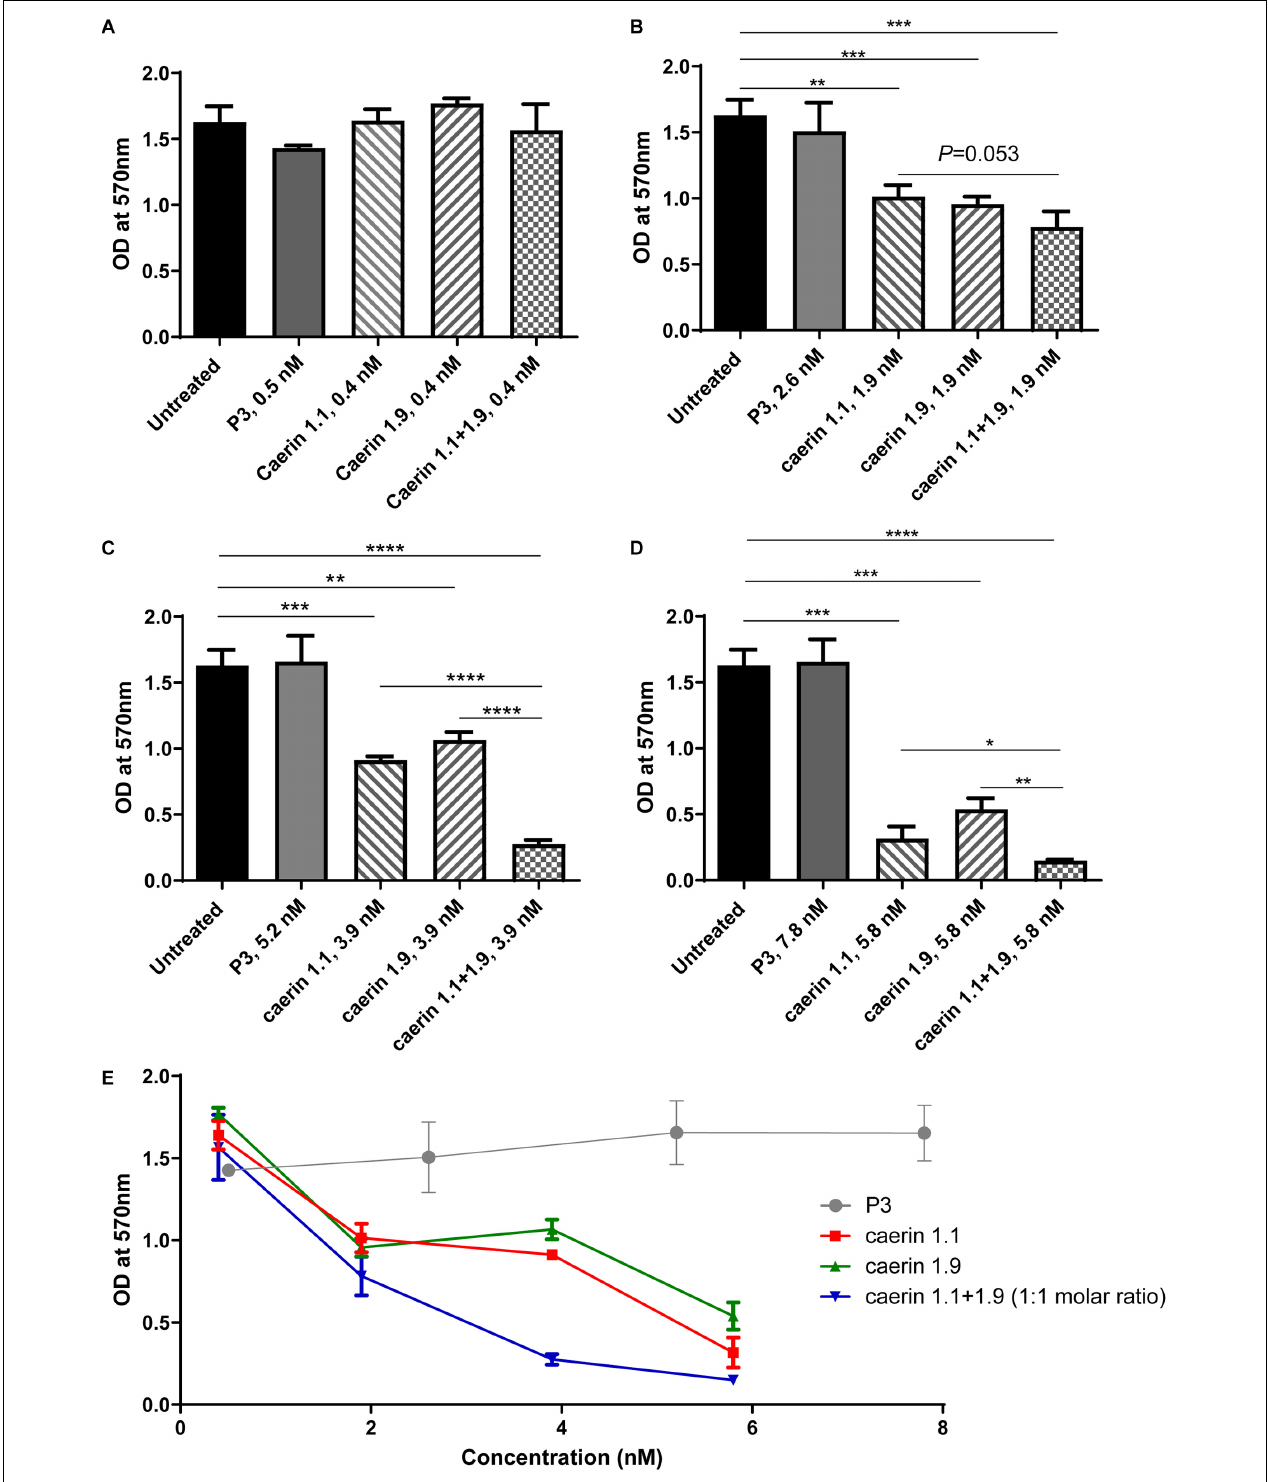
FIGURE 1 | Caerin 1.1 and 1.9 inhibited the proliferation of HeLa cells by MTT assay. 1 × 10 4 of HeLa cells were cultured in media only, or also with different concentrations of caerin 1.1, 1.9, P3 or the mixture of caerin 1.1/1.9 (molar ratio 1:1) for 24 h before MTT assay was performed. (A) 0.4 nM (0.5 nM for P3), (B) 1.9 nM (2.5 nM for P3), (C) 3.9 nM (5.2 nM for P3), (D) 5.8 nM (7.8 nM for P3), and (E) the dose dependency of activities. Each bar represents the statistical mean from three biological replicates (performed in triplicate) and the error bars represent the standard deviation. * P < 0.05, ** P < 0.01, *** P < 0.001, **** P < 0.0001, two-tailed Student T